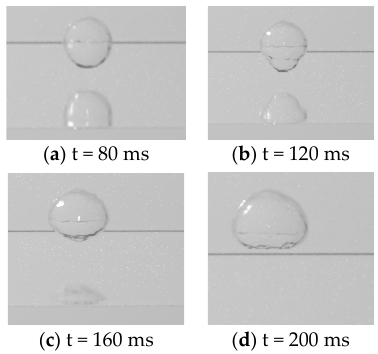
Figure 7. Bubble generation effect of the method in this paper.